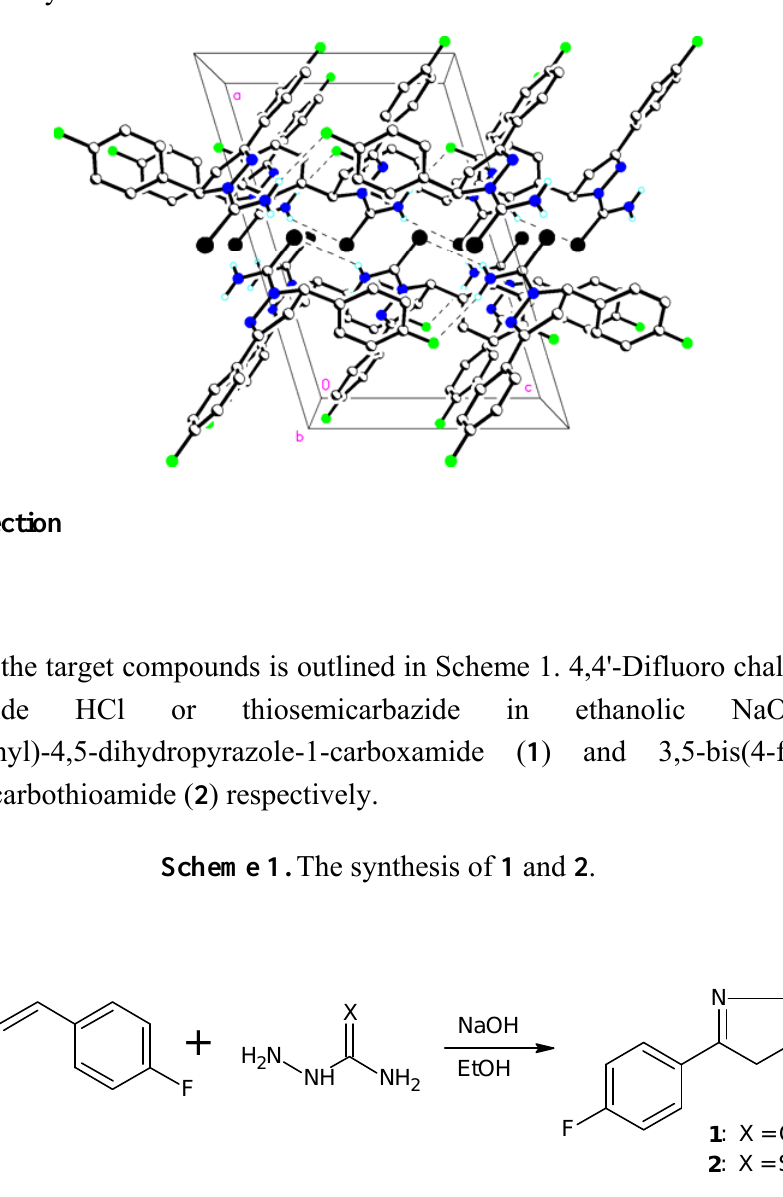
Figure 5. Packing diagram of 2 viewed along the b axis. Dashed lines indicate N–H...F and N–H...S hydrogen bonds forming chains along (001). Remaining H atoms have been removed for